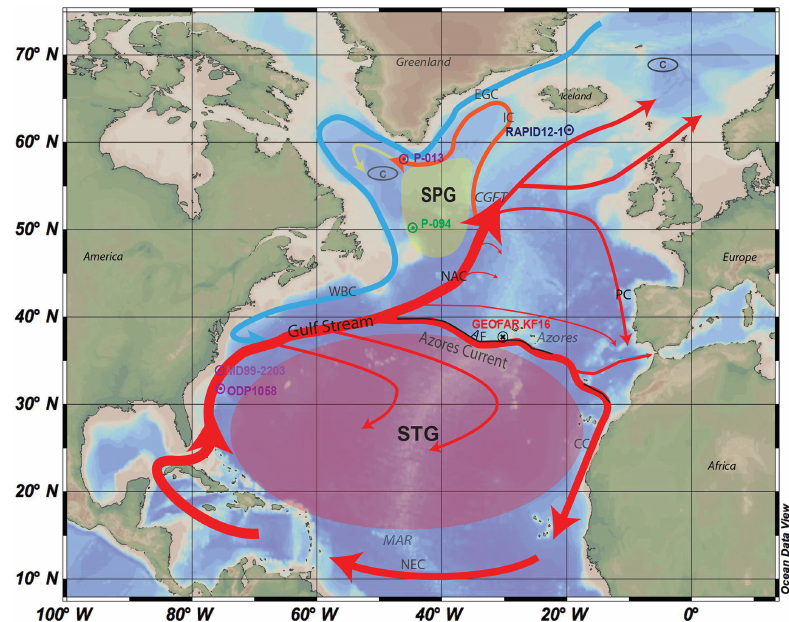
Figure 1. Modern surface water hydrography of the North Atlantic currents are modified from Schott et al. (2004) and Lherminier et al. (2010); basic maps stem from ocean data view (Schlitzer, 2012). Warm surface currents are shown by red arrows. The black line indicates the position of the Azores Front (abbreviations are AC, Azores Current; AF, Azores Front; FC, Florida Current; IC, Irminger Current; NAC, North Atlantic Current; NEC, North Equatorial Current; STG, subtropical gyre; SPG, subpolar gyre; PC, Portugal Current; TW, transitional water; WBC, western boundary current). © symbols indicate the position of deepwater convection sites, and the Mid-Atlantic Ridge is marked with